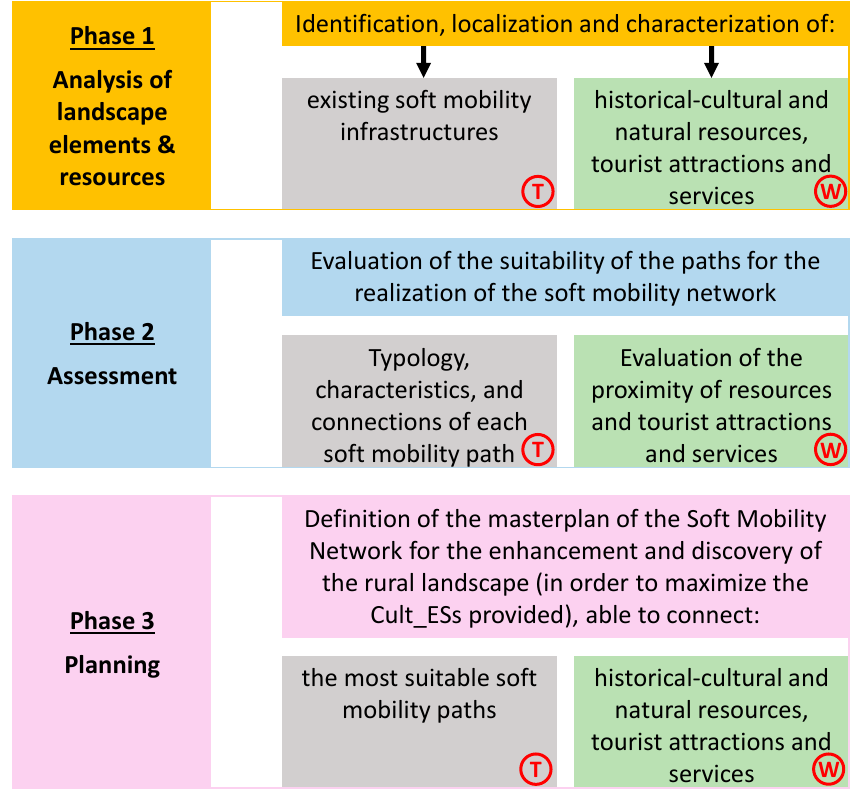
Figure 2. Methodology flow chart.